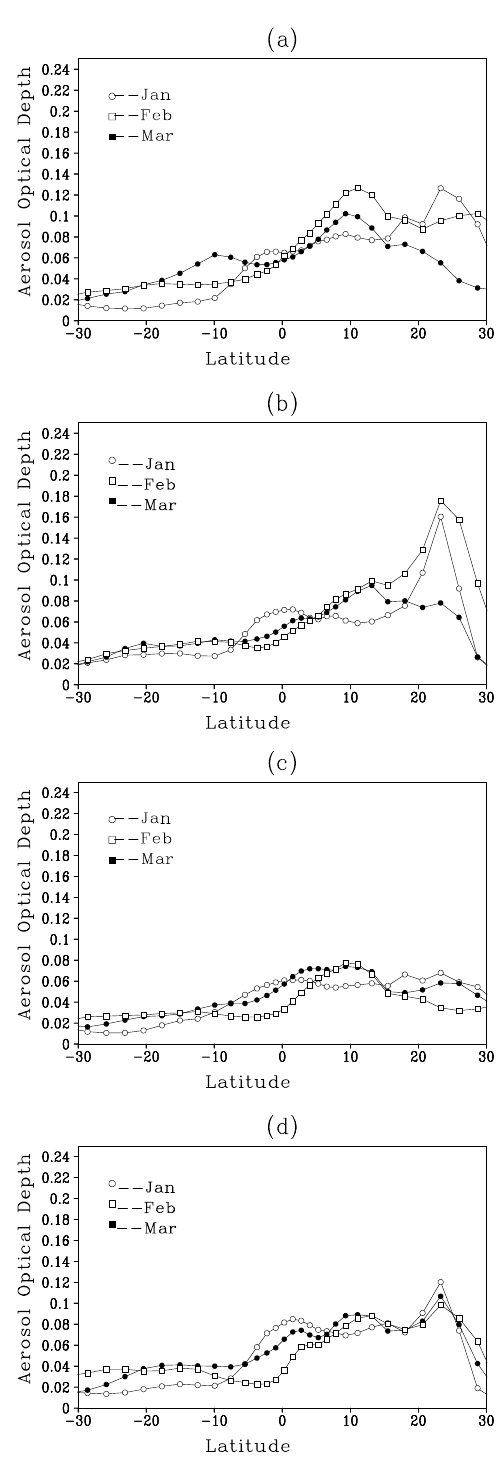
Fig. 8. Latitudinal variations of simulated sulphate AOD. (a) and (c) Arabian Sea sector (60–80 ◦ E), (b) and (d) Bay of Bengal sector (80–100 ◦ E). (a) and (b) are obtained from SCN-RV while (c) and (d) are from